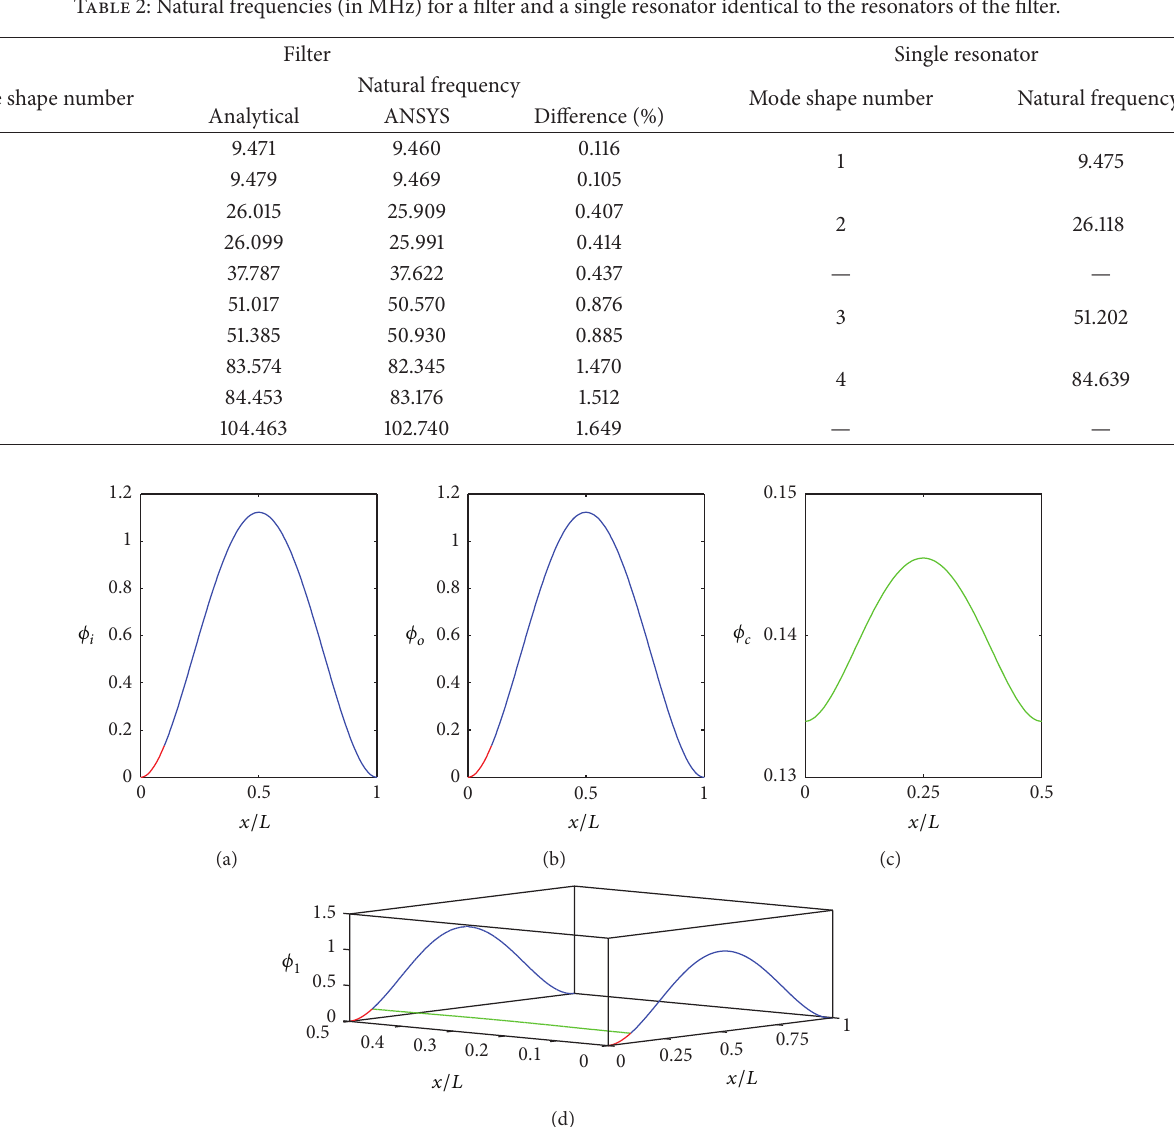
Table 2: Natural frequencies (in MHz) for a filter and a single resonator identical to the resonators of the filter.